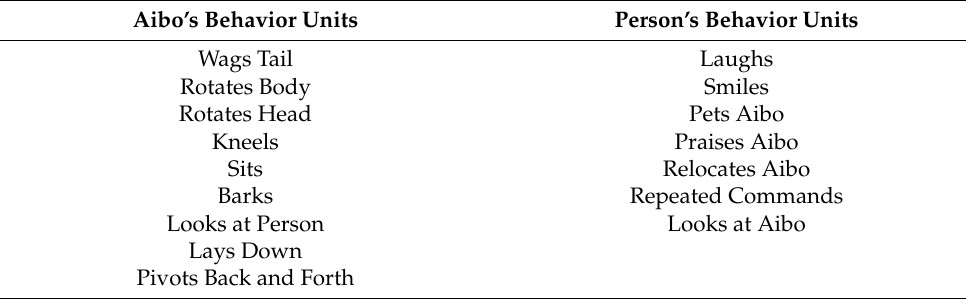
Table 2. Behavioral units recorded within the video per and between Aibo and